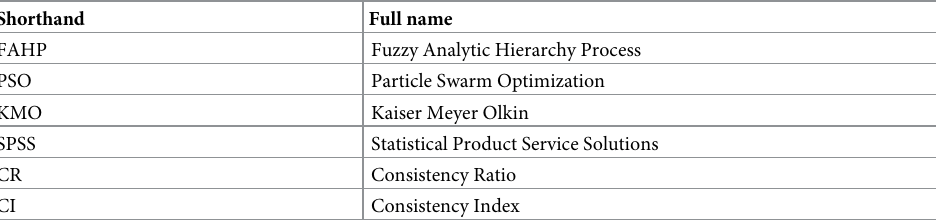
Table 2. Fuzzy AHP score.